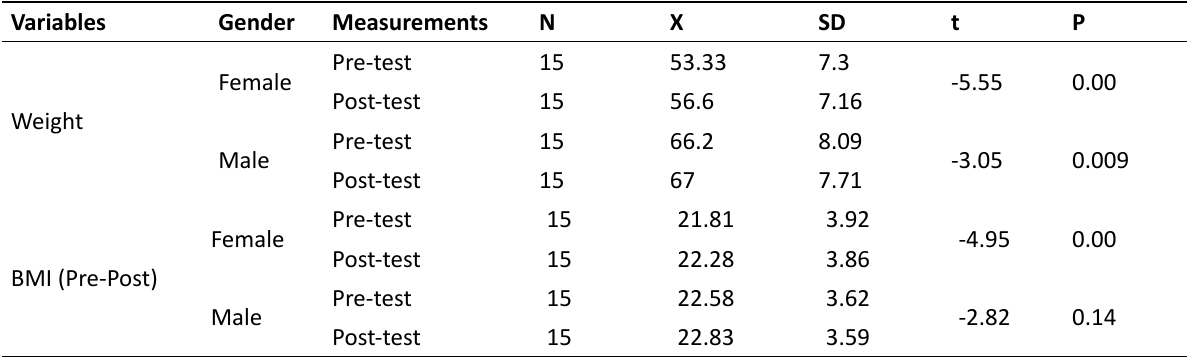
Height Table 2. The Pre-test and Post-test Results of the Participant Females and Males Concerning the Weight and BMI (Body Mass Index) Variables